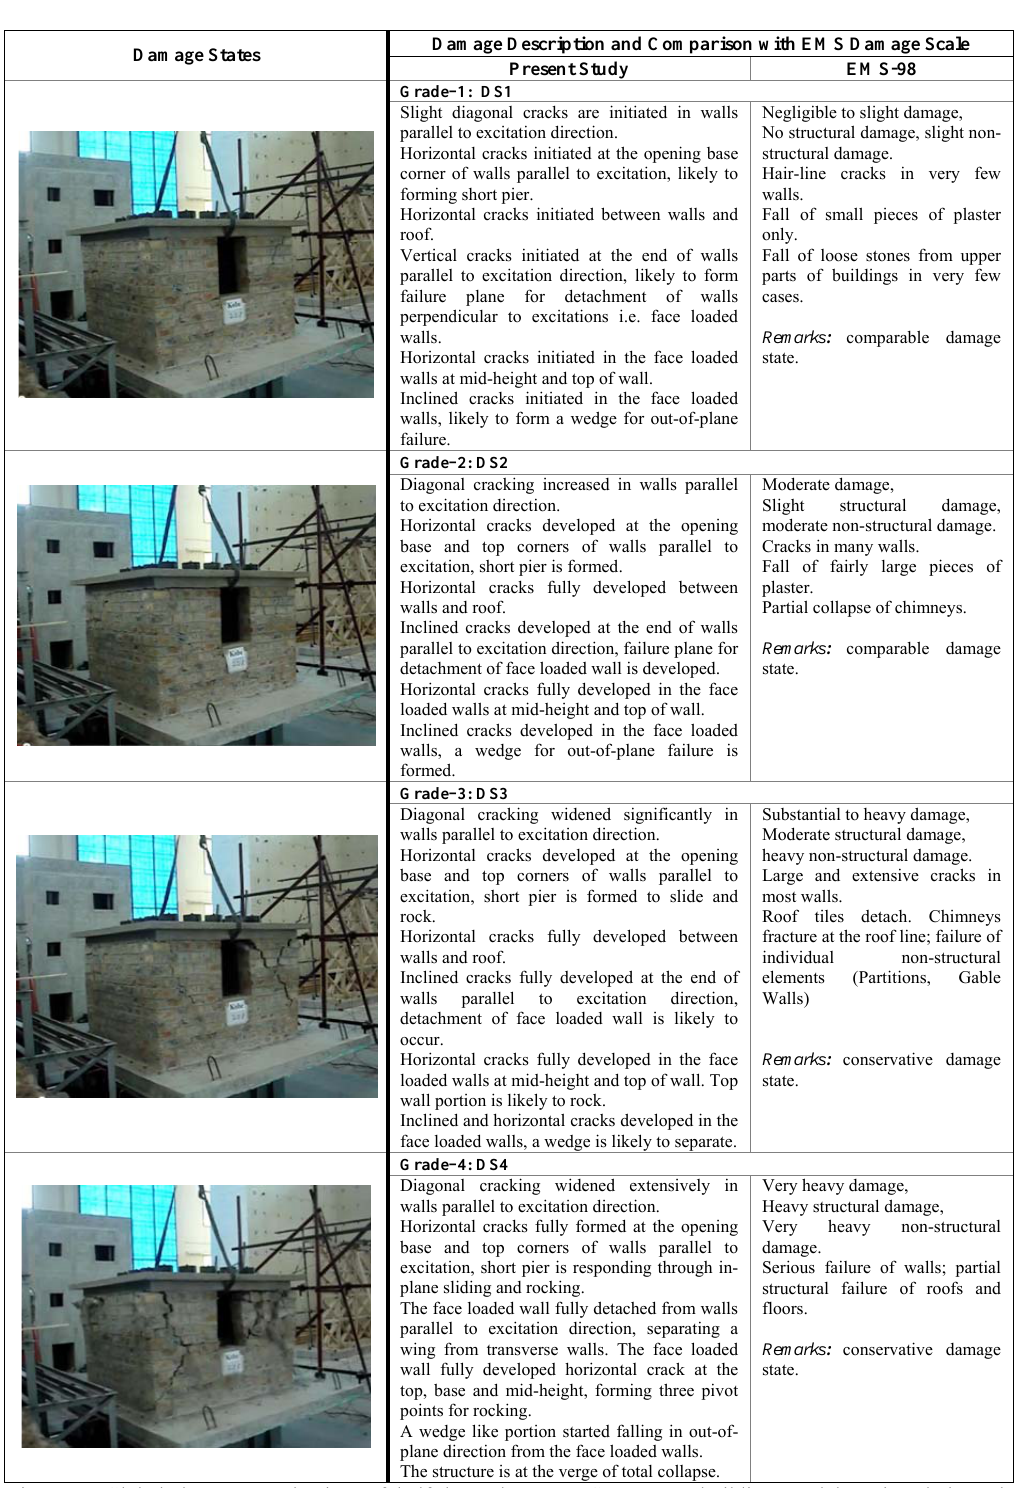
Fig. 5. Global damage mechanism of half-dressed stone DS masonry building model retrieved through dynamic shake table test and comparison with the EMS-98 (Grunthal et al., 1998) damage scale. From left to right: observed damage state, damage state label and description of observed and EMS damage